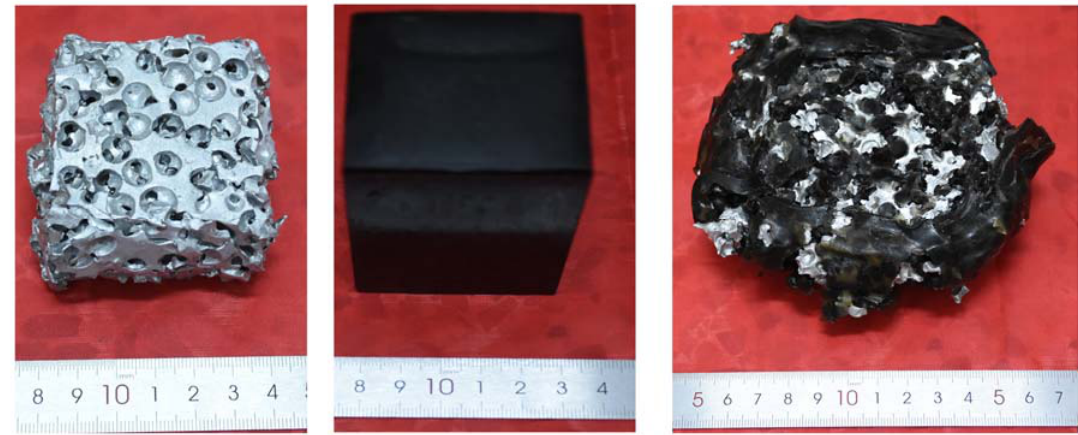
Figure 3. Deformed SCPA, PU and SCPA-PU composites specimens after uniaxial compression tests.